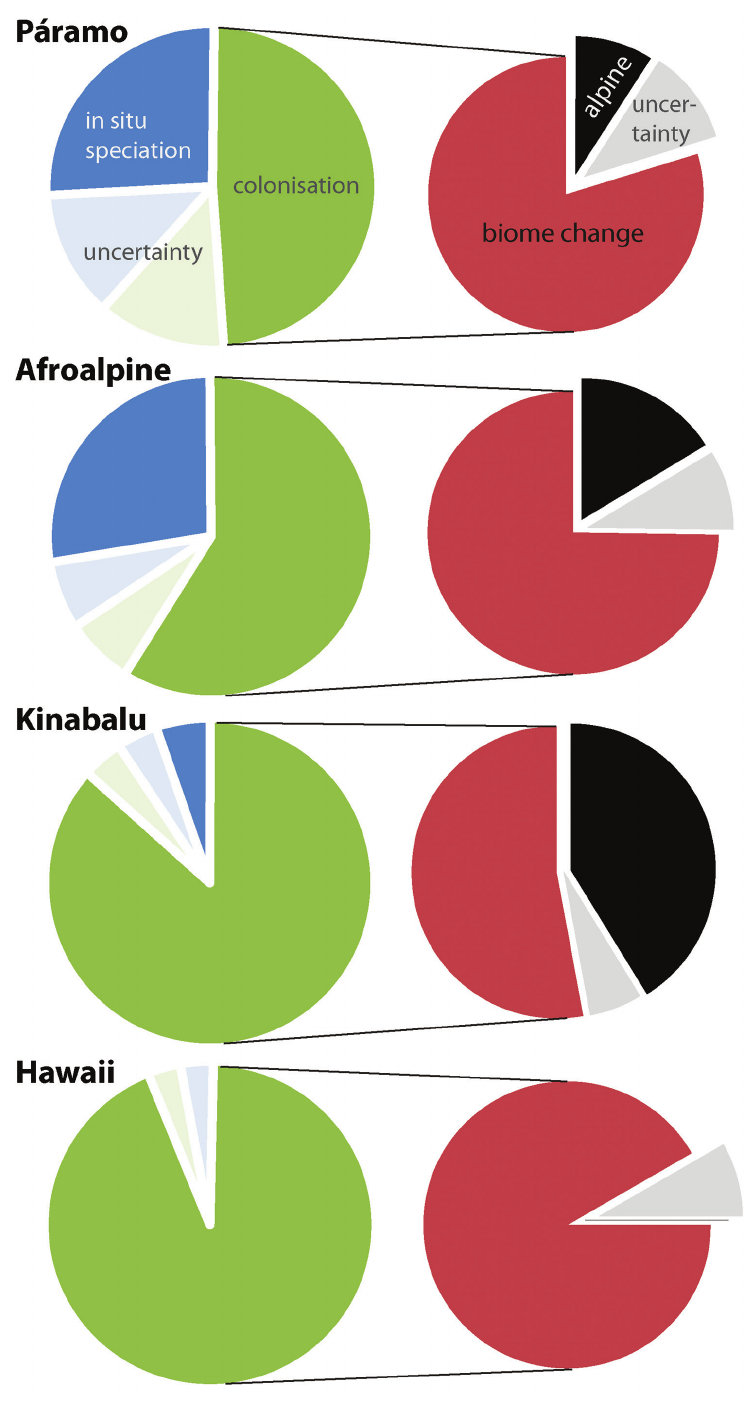
Figure 3. Proportion of plant elements in tropical alpine regions based on generic distribution patterns according to Smith and Cleef